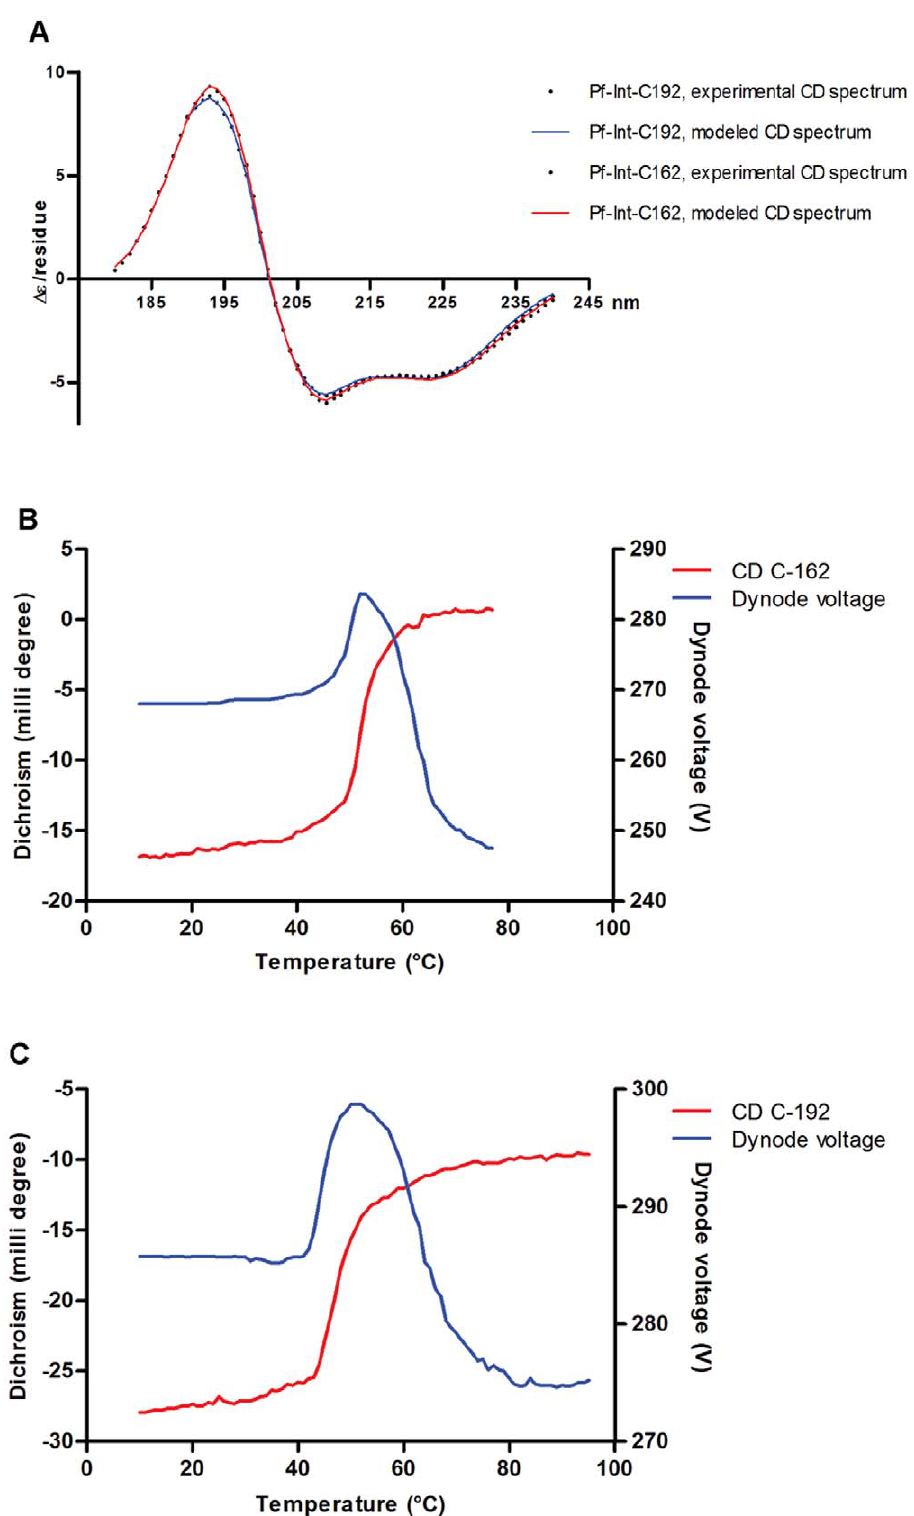
Figure 3. Circular dichroism analysis of the purified recombinant proteins Pf-Int-C162 and Pf-Int-C192. A ) CD analysis in far UV. Black dots: experimental CD data. Blue line: modeled CD spectra of Pf-Int-C192. Red line: modeled CD spectra of Pf-Int-C162. The CD spectral analysis showed for both analyzed forms a high degree of a -helical organization and a low percentage of b -sheet (54/60% a -helical and 6/3% b -sheet for Pf- Int-C162/C192). B, C ) Stability analysis by thermal denaturation coupled to CD for B ) Pf-Int-C162 and C ) Pf-Int-C192. Thermal CD transition curves (red lines) for Pf-Int-C162 and Pf-Int-C192 showed a beginning of stability change at approximately 50 u C and 40 u C, with a completion at 60 u C and 50 u C. The increase of the dynode signal (blue lines) indicates that the proteins are precipitating at the transition and thus the melting temperatures cannot be precisely determined. doi:10.1371/journal.pone.0046507.g003 PLOS ONE |